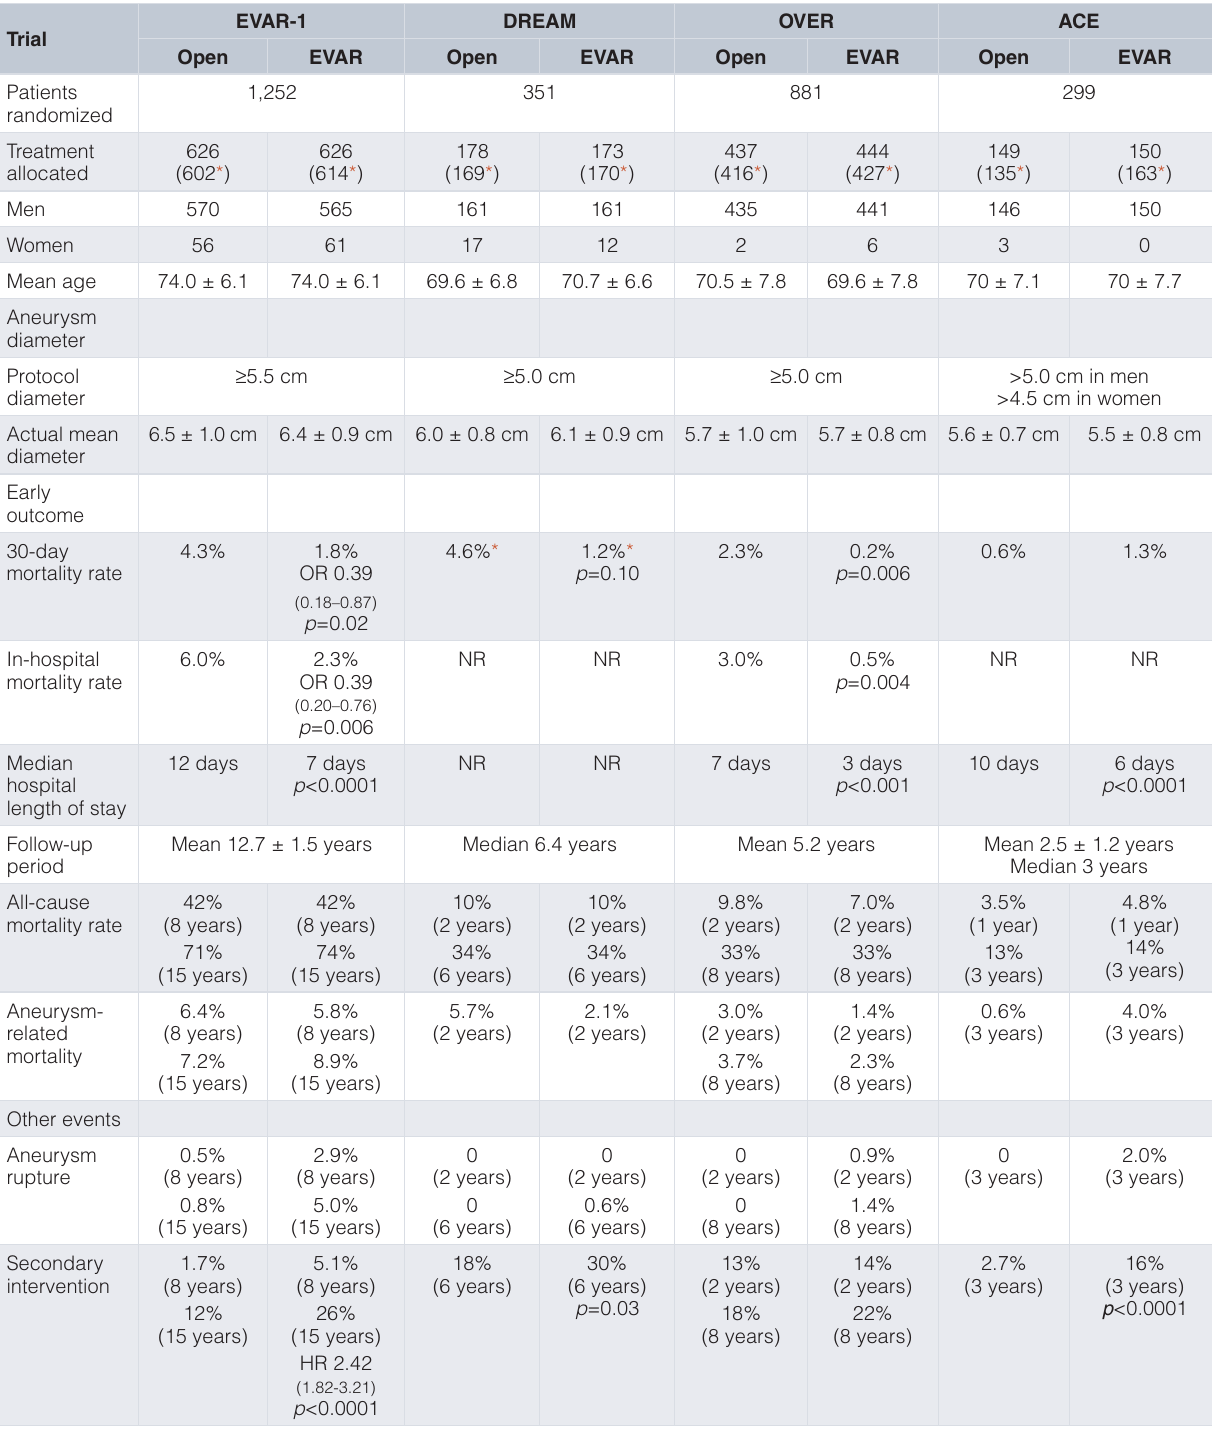
Table 2. Intention-to-treat analysis of open versus endovascular repair for non-ruptured abdominal aortic aneurysms in the randomized EVAR-1 32–34 , DREAM 35–37 , OVER 39–40 , and ACE 44 trials.